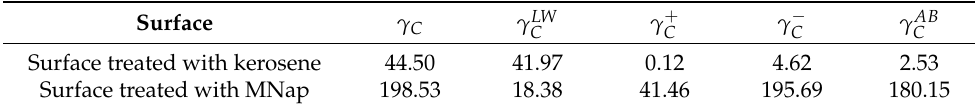
Table 5. Surface free energy parameters of collectors (mJ/m 2